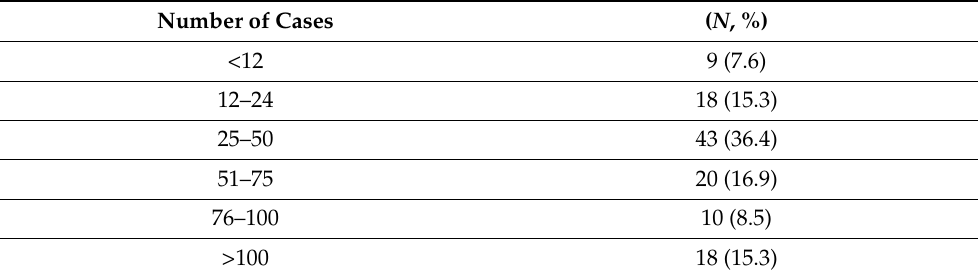
Table 1. Number of cases of appendicitis per year, per respondent.